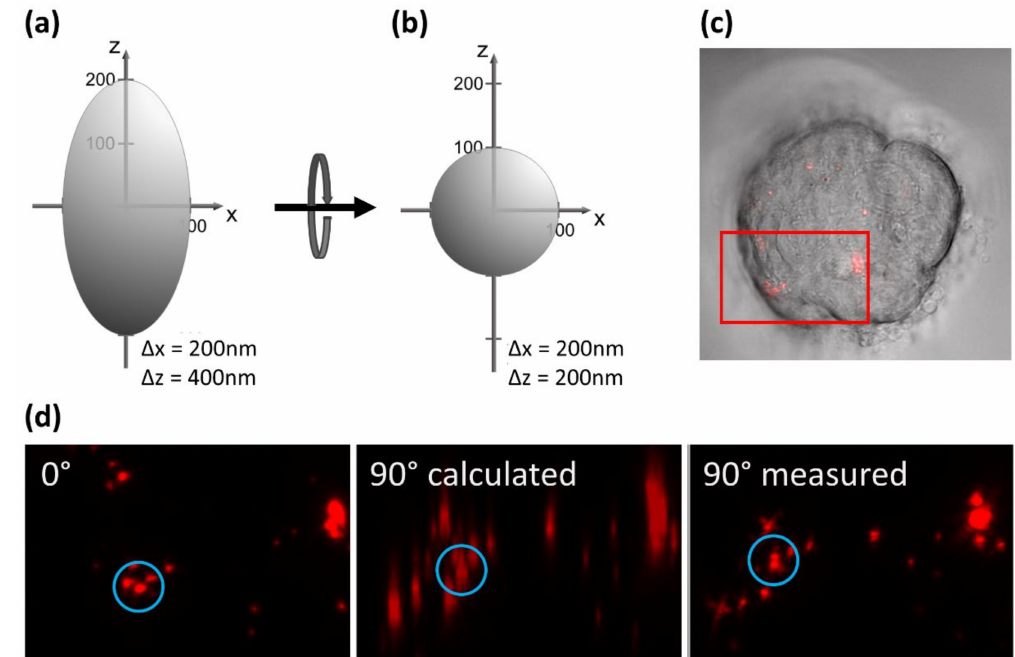
Figure 5. Principle of axial tomography. Optimization of the point-spread function in view of an isotropic high resolution ( a , b ); MCF-7 breast carcinoma cell incubated with 20 nm quantum dots ( c ); fluorescence under 0 ◦ (top view) and 90 ◦ (side view calculated from a z-stack at 0 ◦ or measured after rotation, ( d ); laser scanning microscopy using a 63/0.9 water immersion objective lens; λ ex = 488 nm, λ em 560 ≥